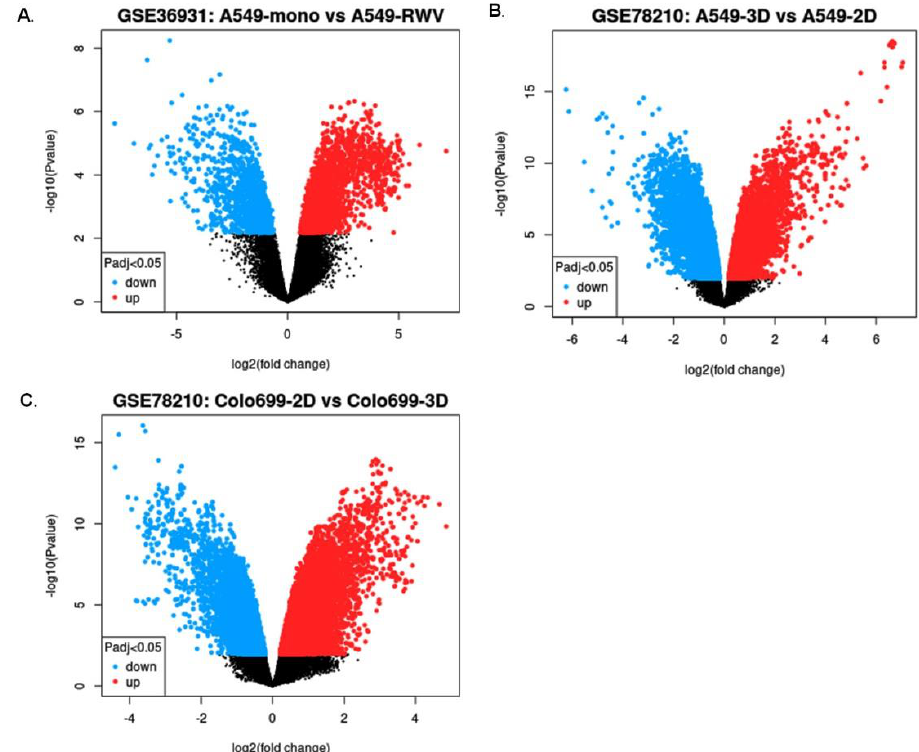
Figure 1. Volcano plot showing differentially expressed genes (DEGs) using GEO Omnibus. ( A ) Volcano plot showing DEGs under SMG and GG effects in A549 cells using ( A ) GSE78210 and ( B ) GSE36931 datasets. ( C ) Volcano plot showing DEGs under SMG and GG effects in Colo699 cell line using GSE78210 dataset. Red color indicates upregulated genes, while blue color indicates downregulated genes. Table 1. Total genes that are differentially expressed at SMG compared with GG in lung cancer cell lines A549 and Colo699. Each dataset had fold changes adjusted to extract the top 5% of DEGs. For GSE36931, fold change (FC) was adjusted to include only genes with an FC greater than or equal to 4 or less than or equal to − 4. For GSE78210, FC was adjusted to include only genes with an FC greater than or equal to 3 or less than or equal to −